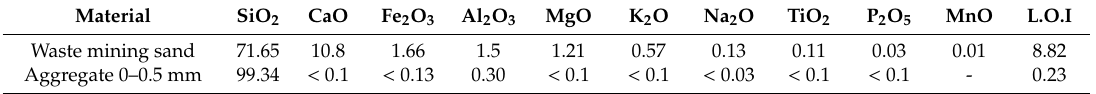
Table 2. Chemical analysis (%) of the waste mining sand and the natural sand it